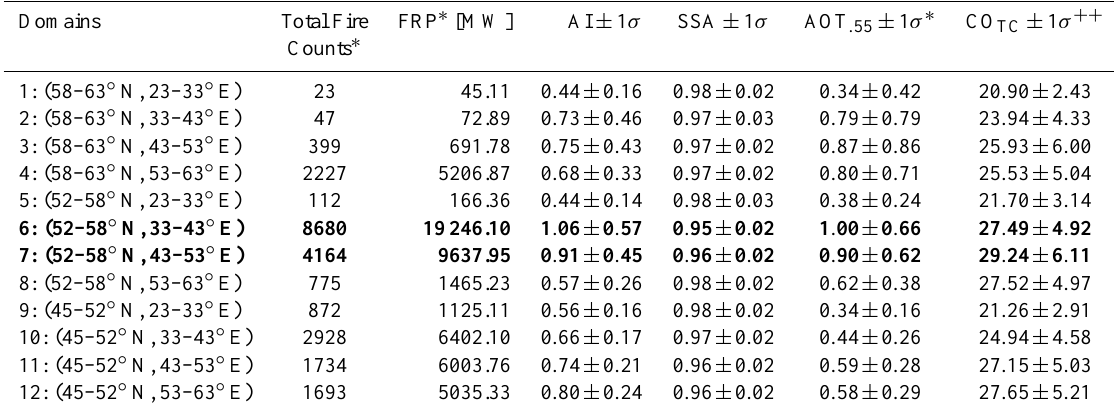
Table 1. Table of mean values (except Fire Counts) within each box domain defined in Fig. 4. These values were calculated over the active fire period from 22 July to 18 August 2010 defined in Fig. 3.